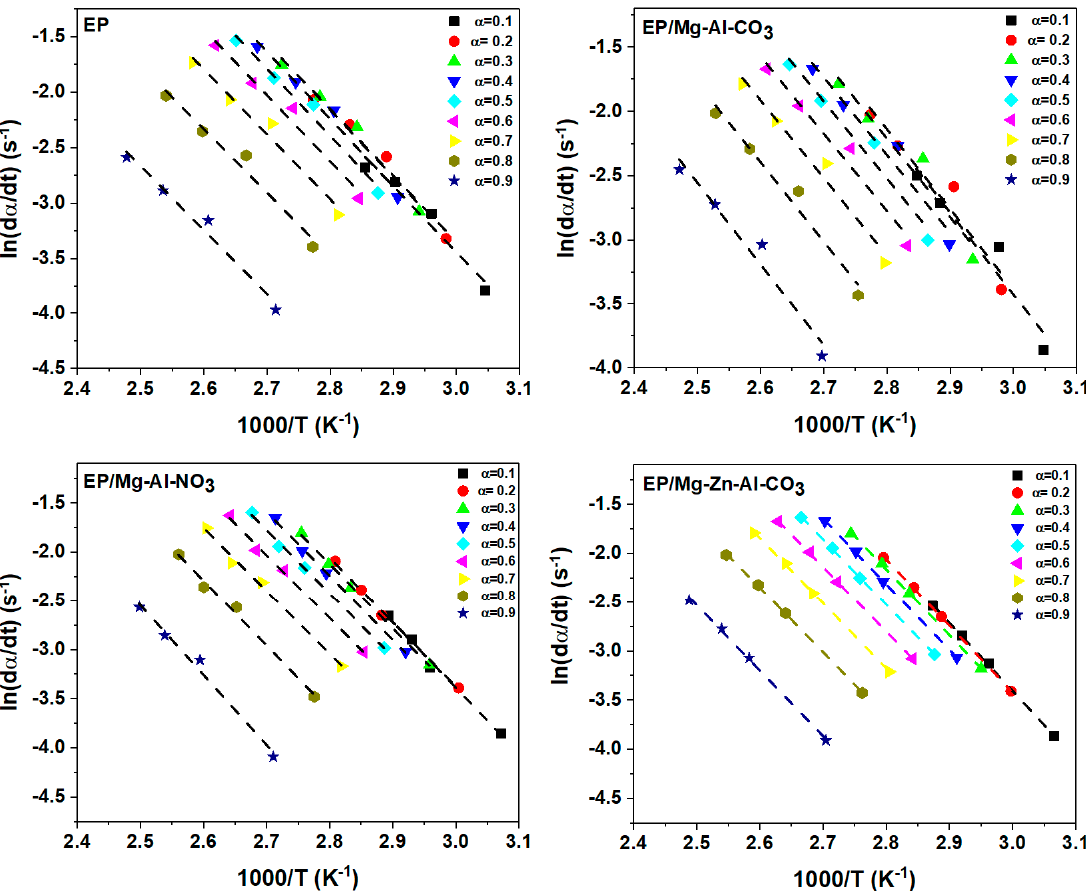
Figure A1. Plots of ln(d α / dt) vs. 1 / T for the prepared samples based on the Friedman model at β = 2 °C ∙ min − 1 .